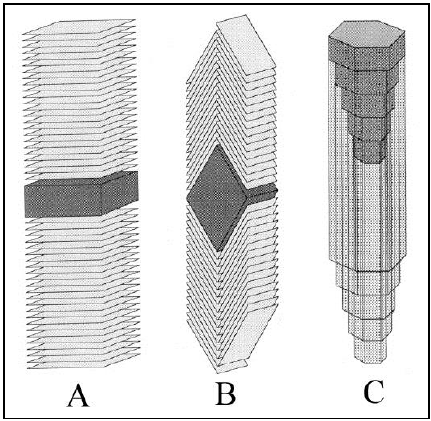
Figure 1. Schematic representations of carbon nanofibers (CNFs): ( A ) “platelet”; ( B ) “herringbone”; and ( C ) “tubular” ([6], Rodriguez et al .,